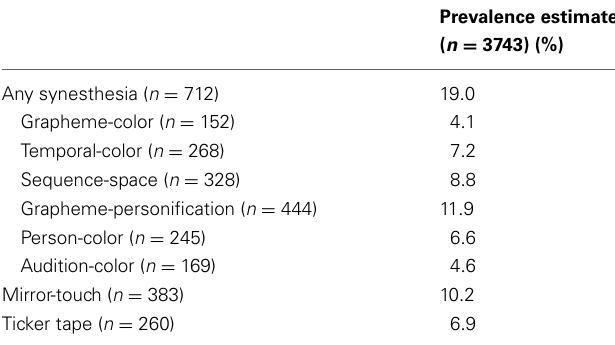
Table 1 | Prevalence